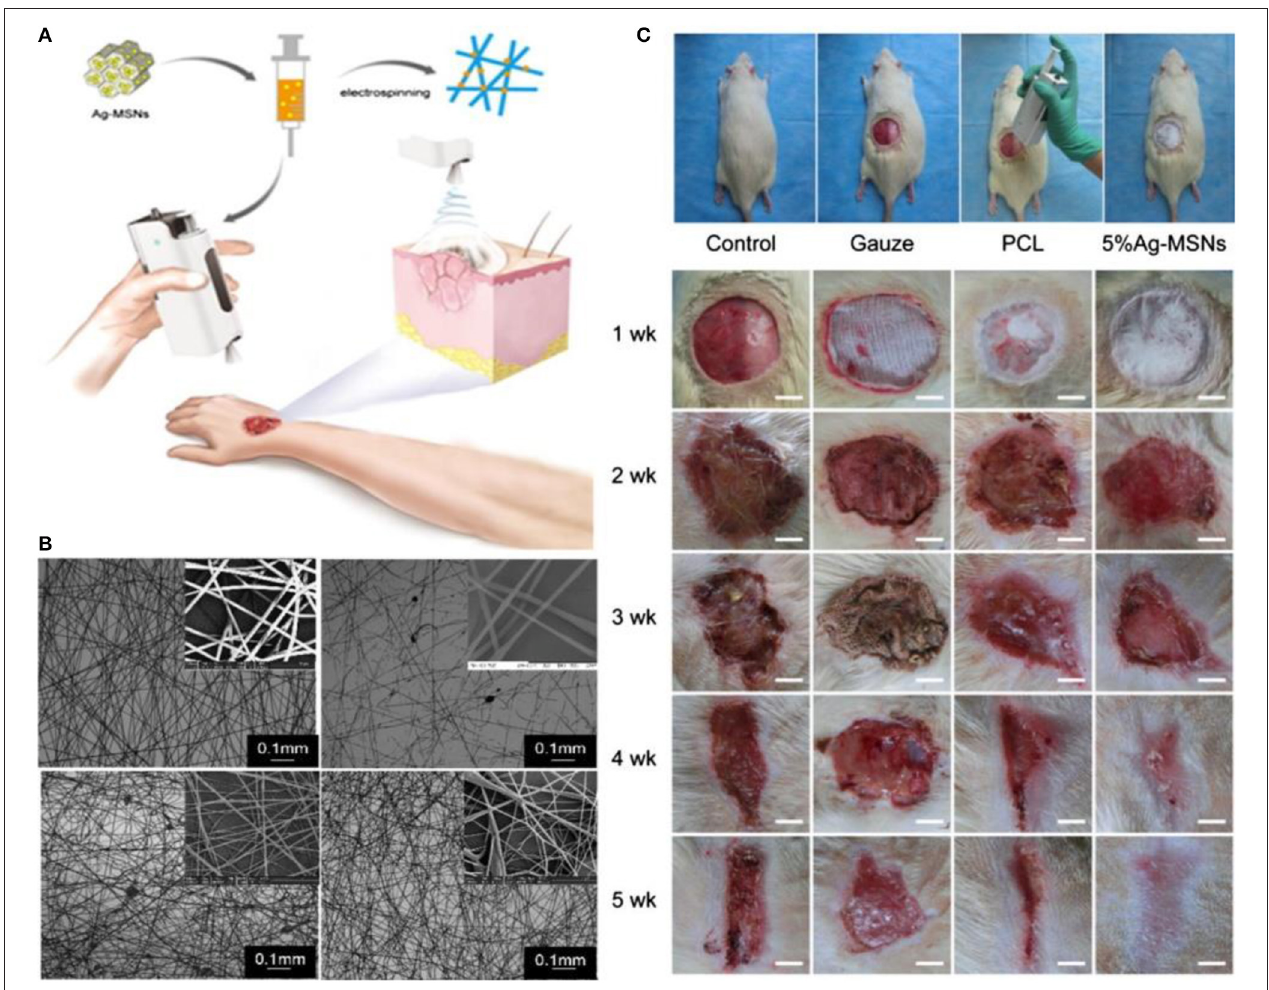
FIGURE 5 | The use of in situ electrospinning process for wound management. (A) Schematic of the process showing the handheld electrospinning system. (B) SEM image of electrospun mats made by the handheld system. (C) In vivo evaluation of in situ electrospun mats, polycaprolactone (PCL), Ag-MSNs -mesoporous silica nanoparticles. Reprinted with permission from Xu et al. (2015) and (Dong et al., 2016). Copyright 2015 and 2016, Royal Society of